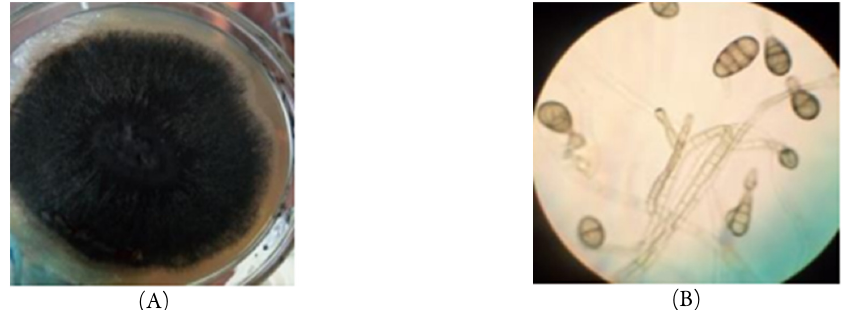
Figure 1. Result of macro and microscopic observation of the endophytic isolate ENa; (A) macroscopic